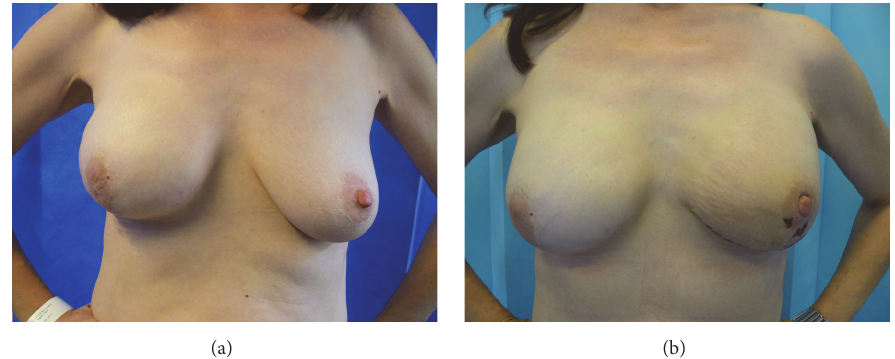
Figure 4: 56-year-old lady underwent risk-reducing surgery on left side 3 years after diagnosis of right breast cancer (Case 4). (a) Pre-op photograph showing right breast reconstruction with implant-expander (traditional dermal sling approach). Left breast has lax skin with minimal ptosis. (b) Post-op photograph after left NSMx with implant reconstruction and right breast implant exchange, demonstrating excellent symmetry. She developed small patches of epidermolysis on areola and surrounding skin, which recovered without any active